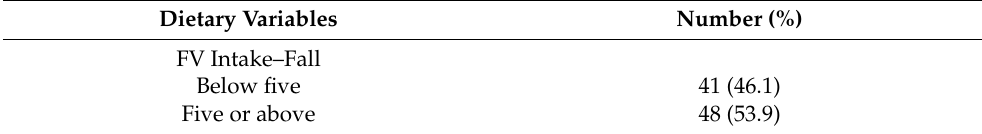
Table 2. Fruits and vegetables (FV) and sugar-sweetened beverages (SSB)